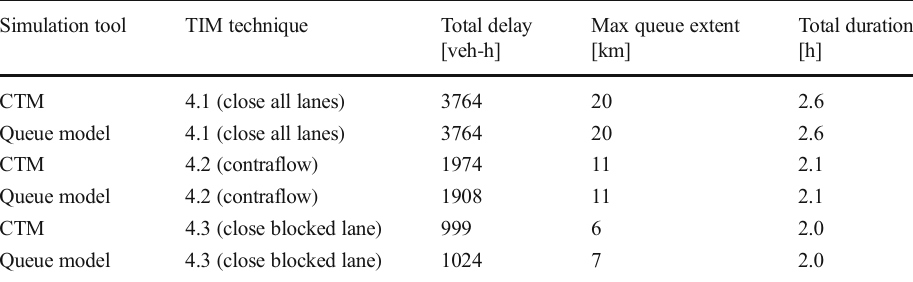
Table 7 Comparing incident estimations simulated by CTM-v and queue model for Scenario 4 (Obstruction), comparing only congested locations upstream of the